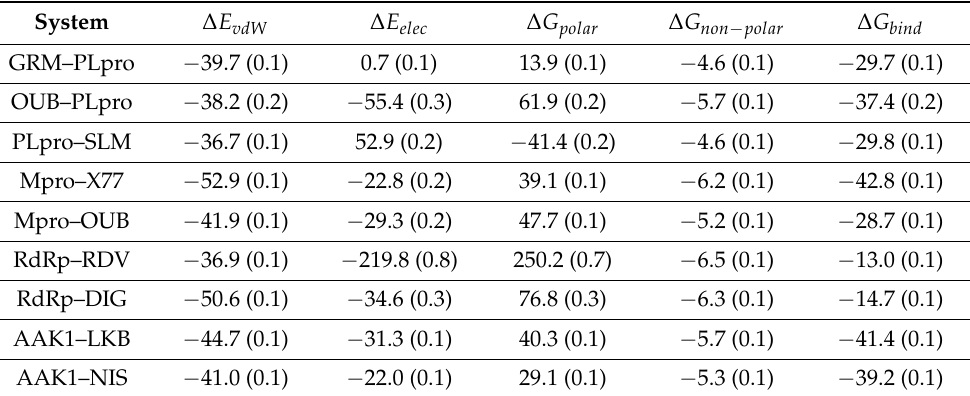
Table 3. Binding free energy ( ∆ G bind ) values and their components for the crystal and repurposed systems by MM/GBSA. The errors were computed by using the single-trajectory protocol [48]. All values are reported in